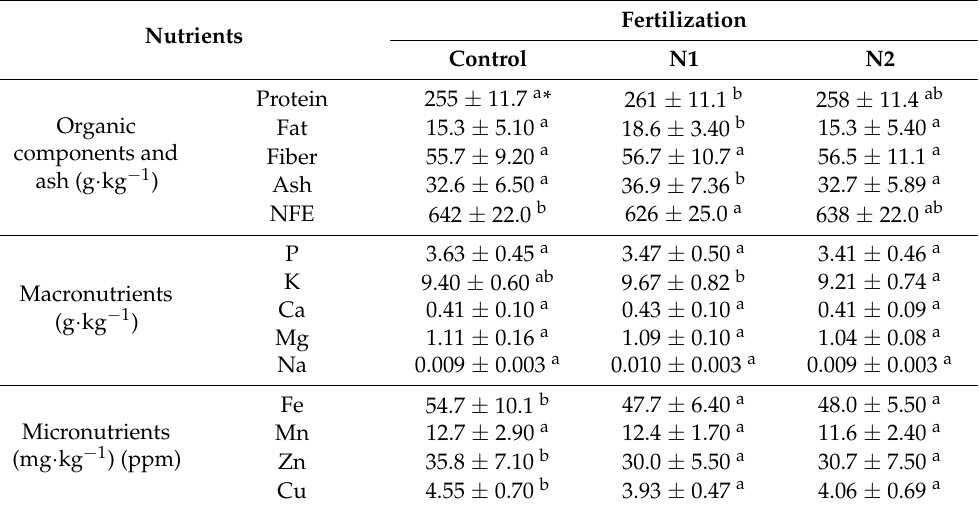
Table 3. Chemical composition of pea seeds depending on foliar fertilization.